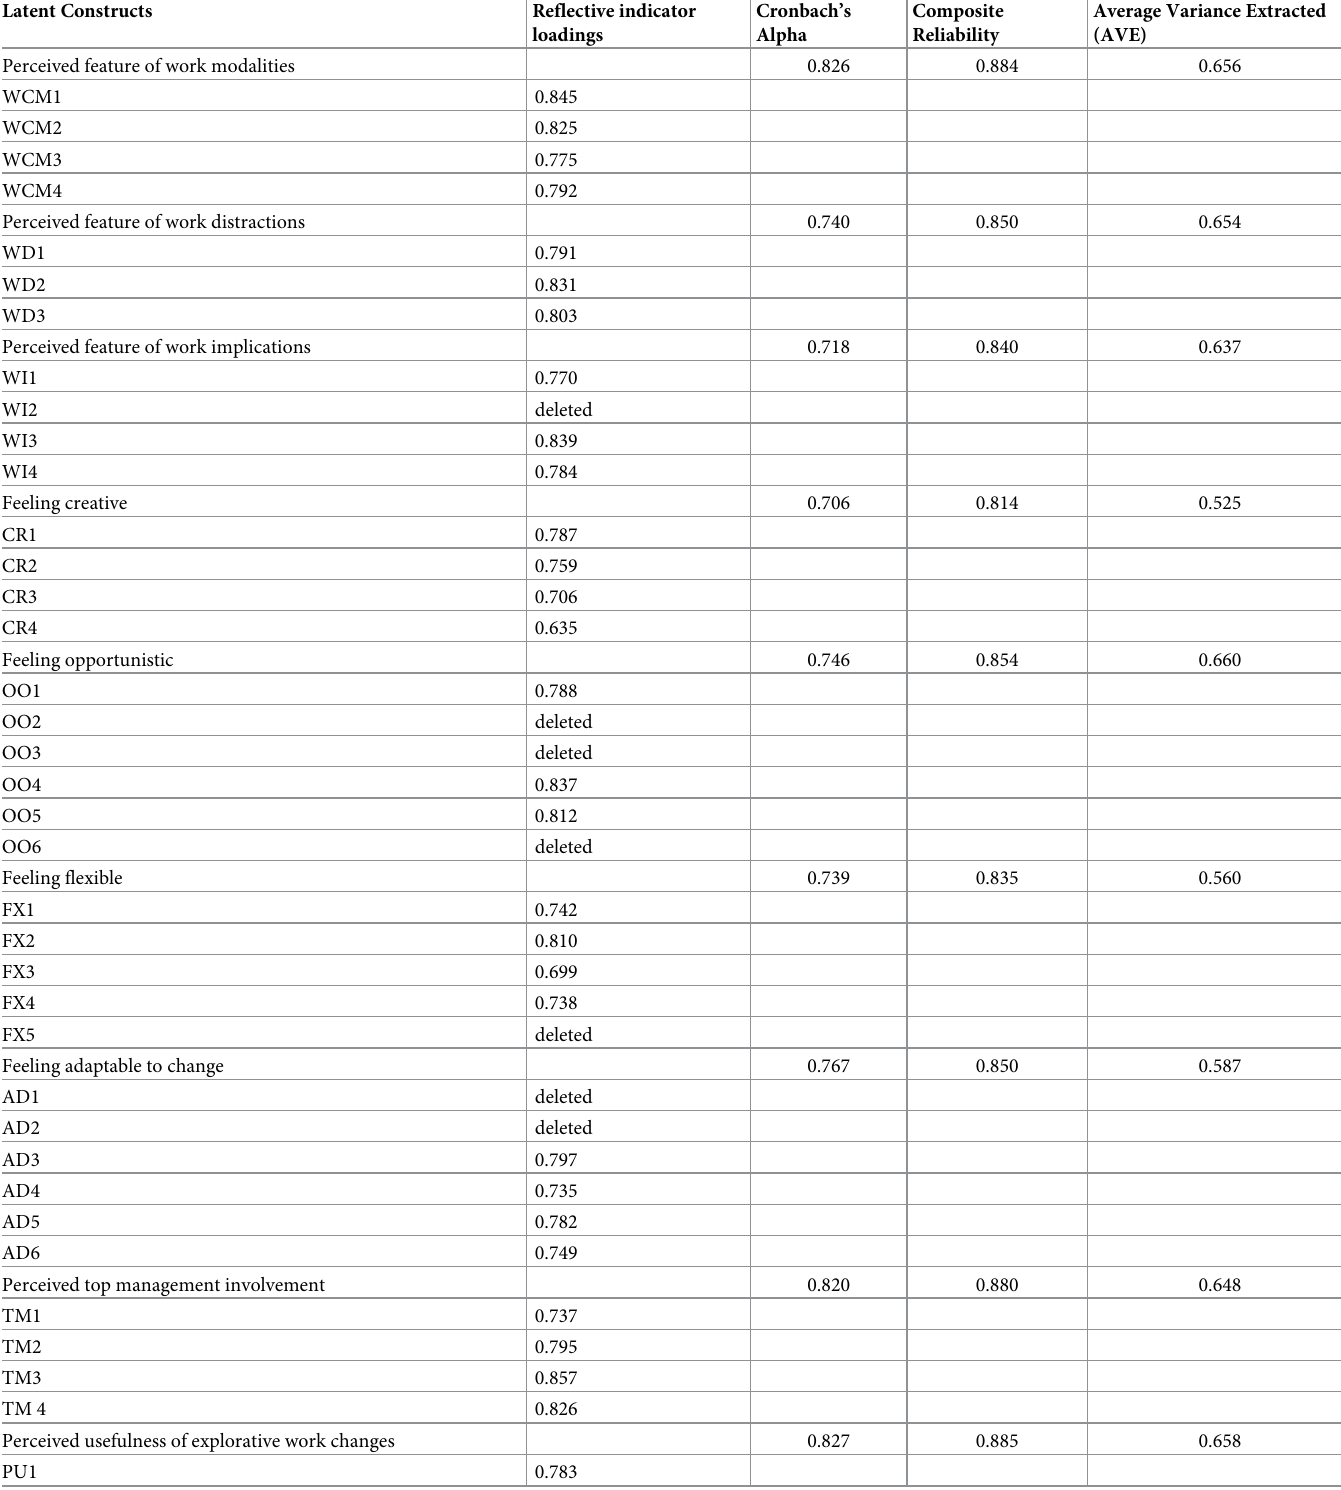
Table 7. Measurement model assessment (loadings, Cronbach’s alpha, CR,